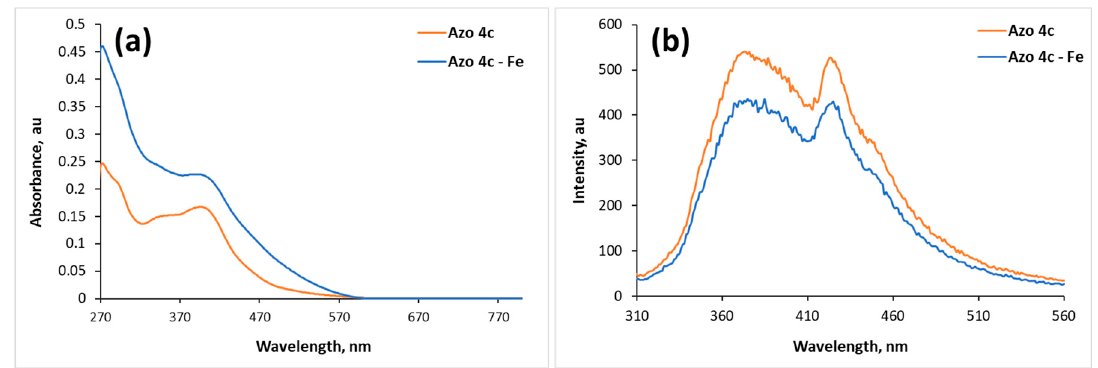
Figure 4. UV/vis absorption spectra of ( a ) azo 4c (2.5 × 10 − 5 M) and ( b ) fluorescence spectra of azo 4c (2.5 × 10 − 5 M) in the absence and presence of Fe 3+ (4 equiv.) in DMF.